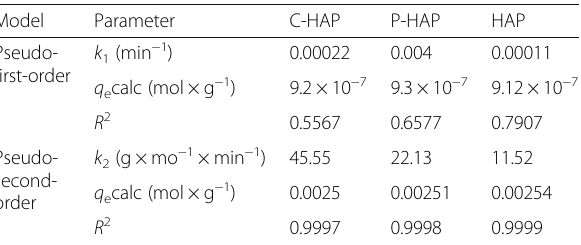
Table 4 Parameters of the kinetic models for the adsorption of the uranium ions on the HAP sorbent